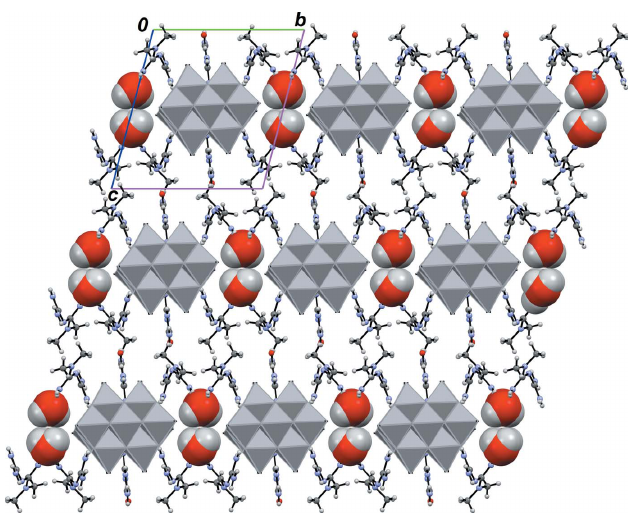
Figure 3 Part of the crystal structure, viewed down the a axis, emphasizing the positions of water molecules (space-fill